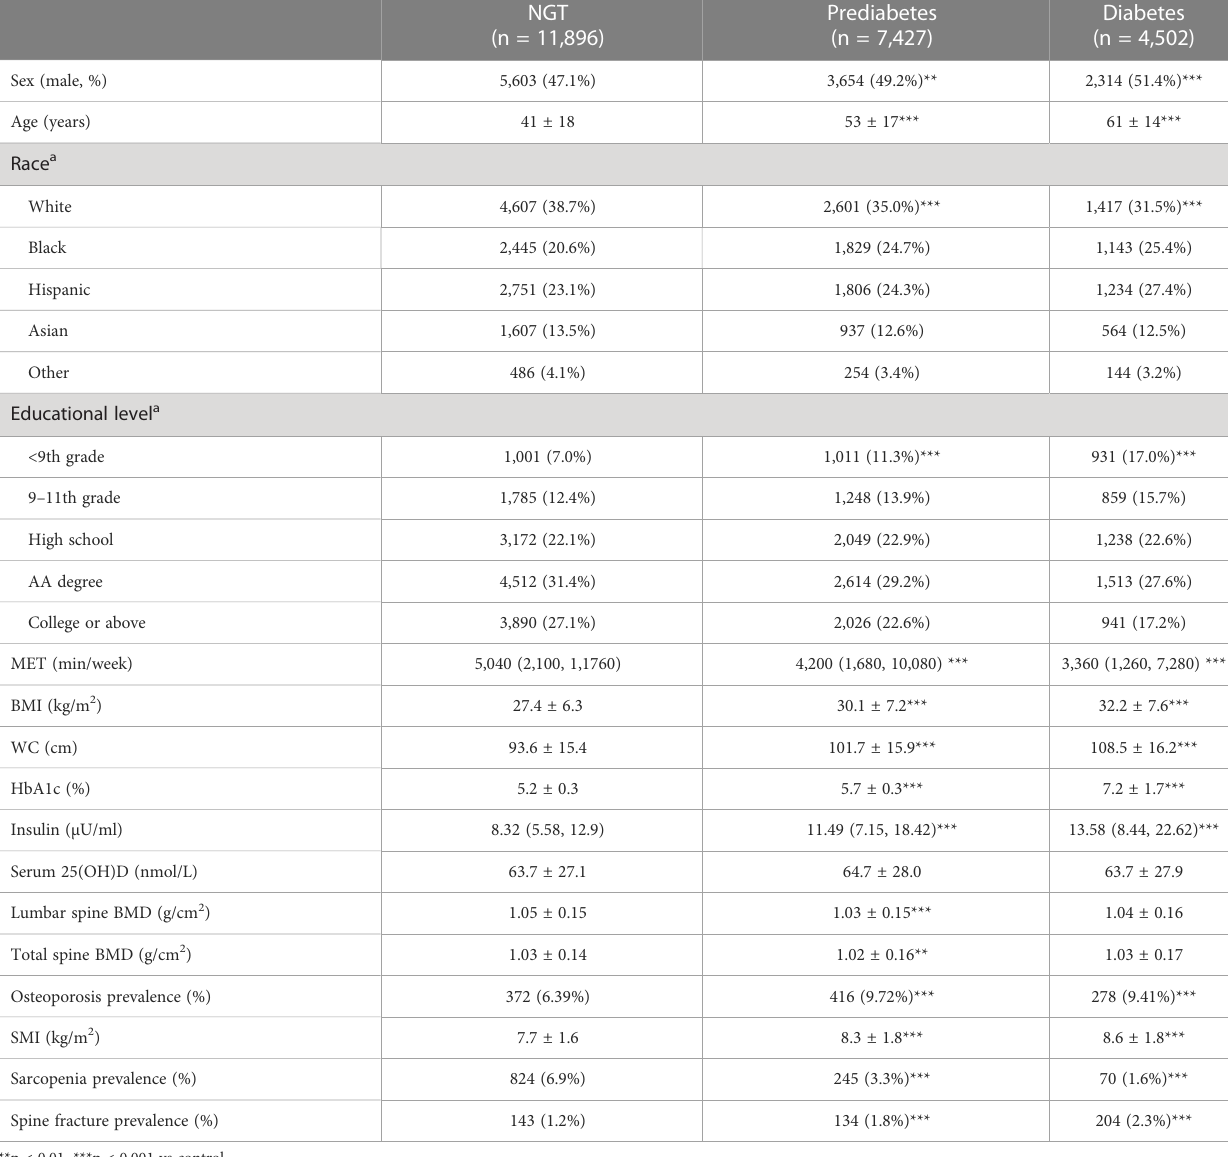
TABLE 1 Characteristics of U.S. adults with diabetes, with prediabetes and with NGT, 2009 –